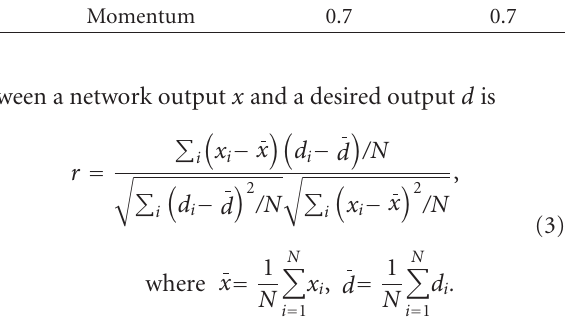
Table 4: Parameters of Fully Recurrent NN (Benchmark